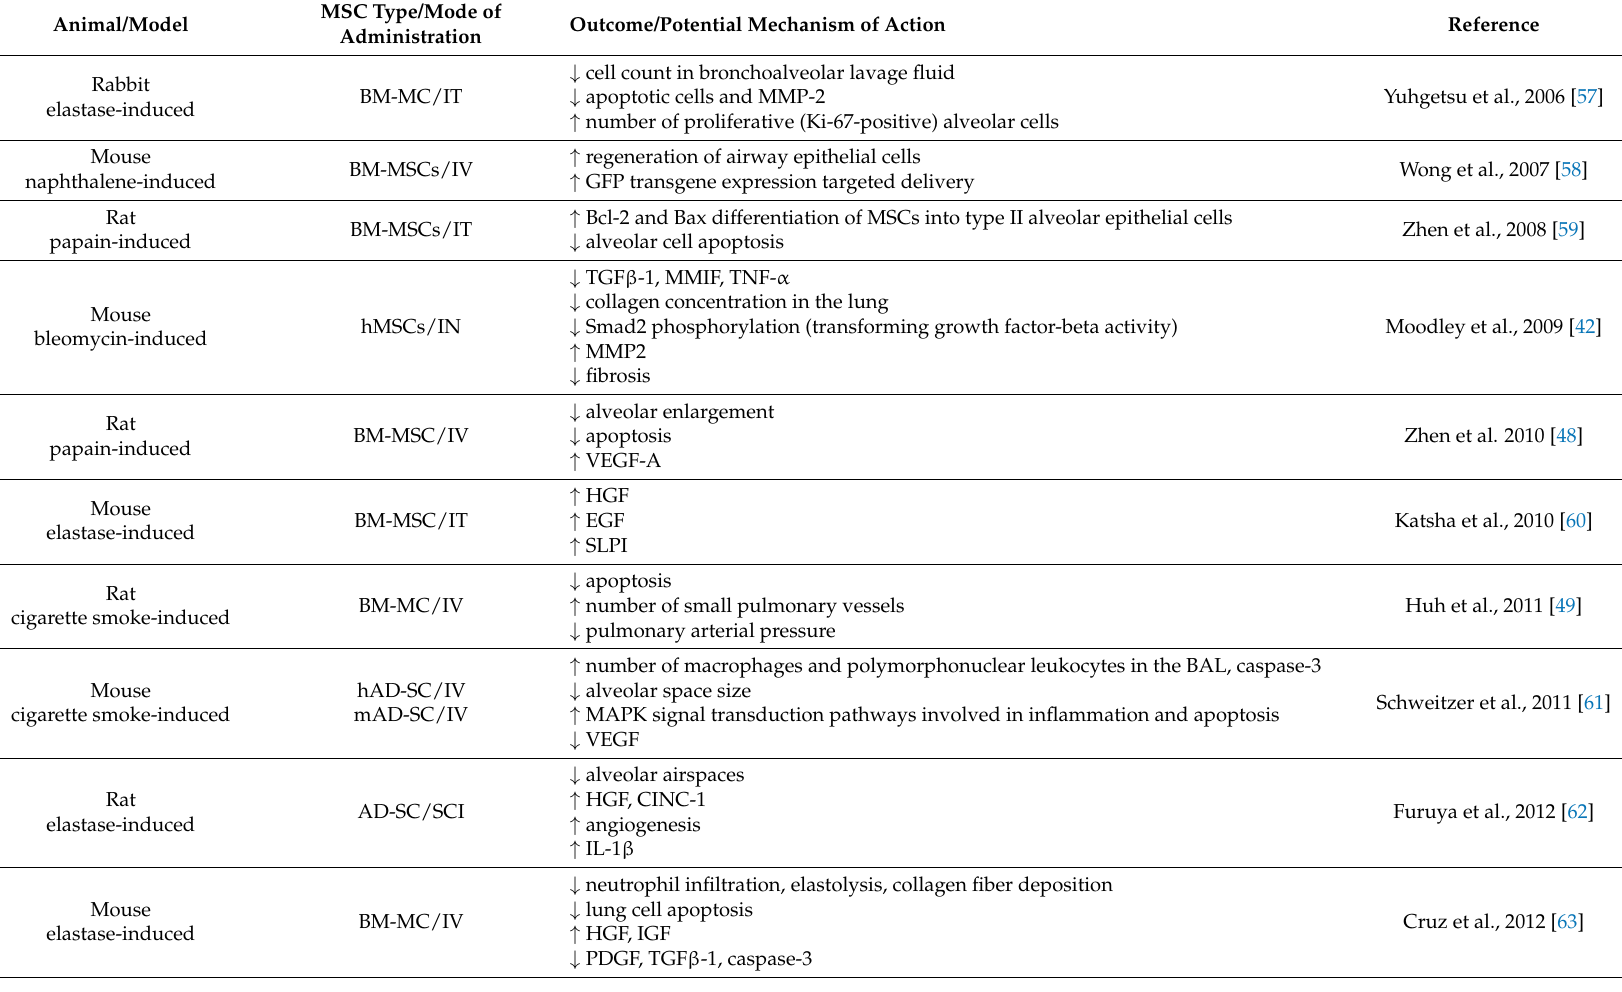
Table 1. In vivo and in vitro effects of mesenchymal stem cells (MSCs) in animal models of chronic obstructive pulmonary disease